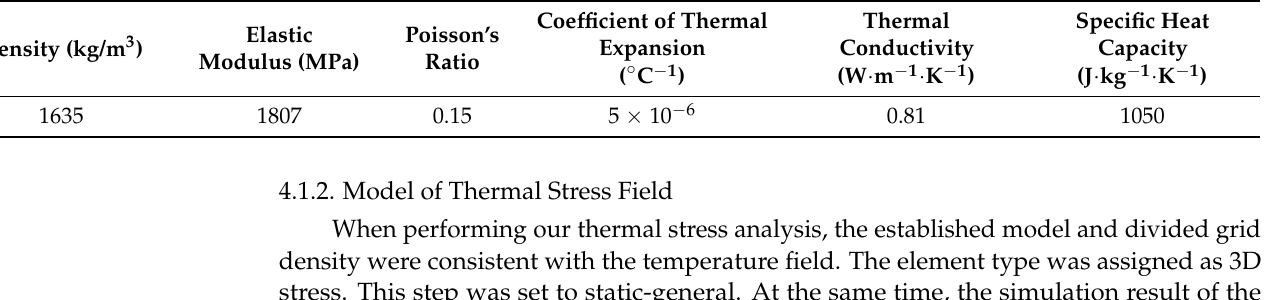
Table 3. Parameters of the gray